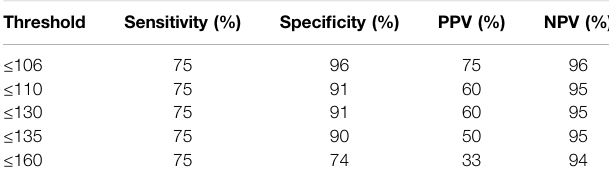
TABLE 2 | Sensitivity, speci fi city, and positive and negative predictive values of various L1 density thresholds indicate osteoporosis when applied to our dataset. The 106 and 130 thresholds were derived from the OSU data, while the other thresholds are found in the